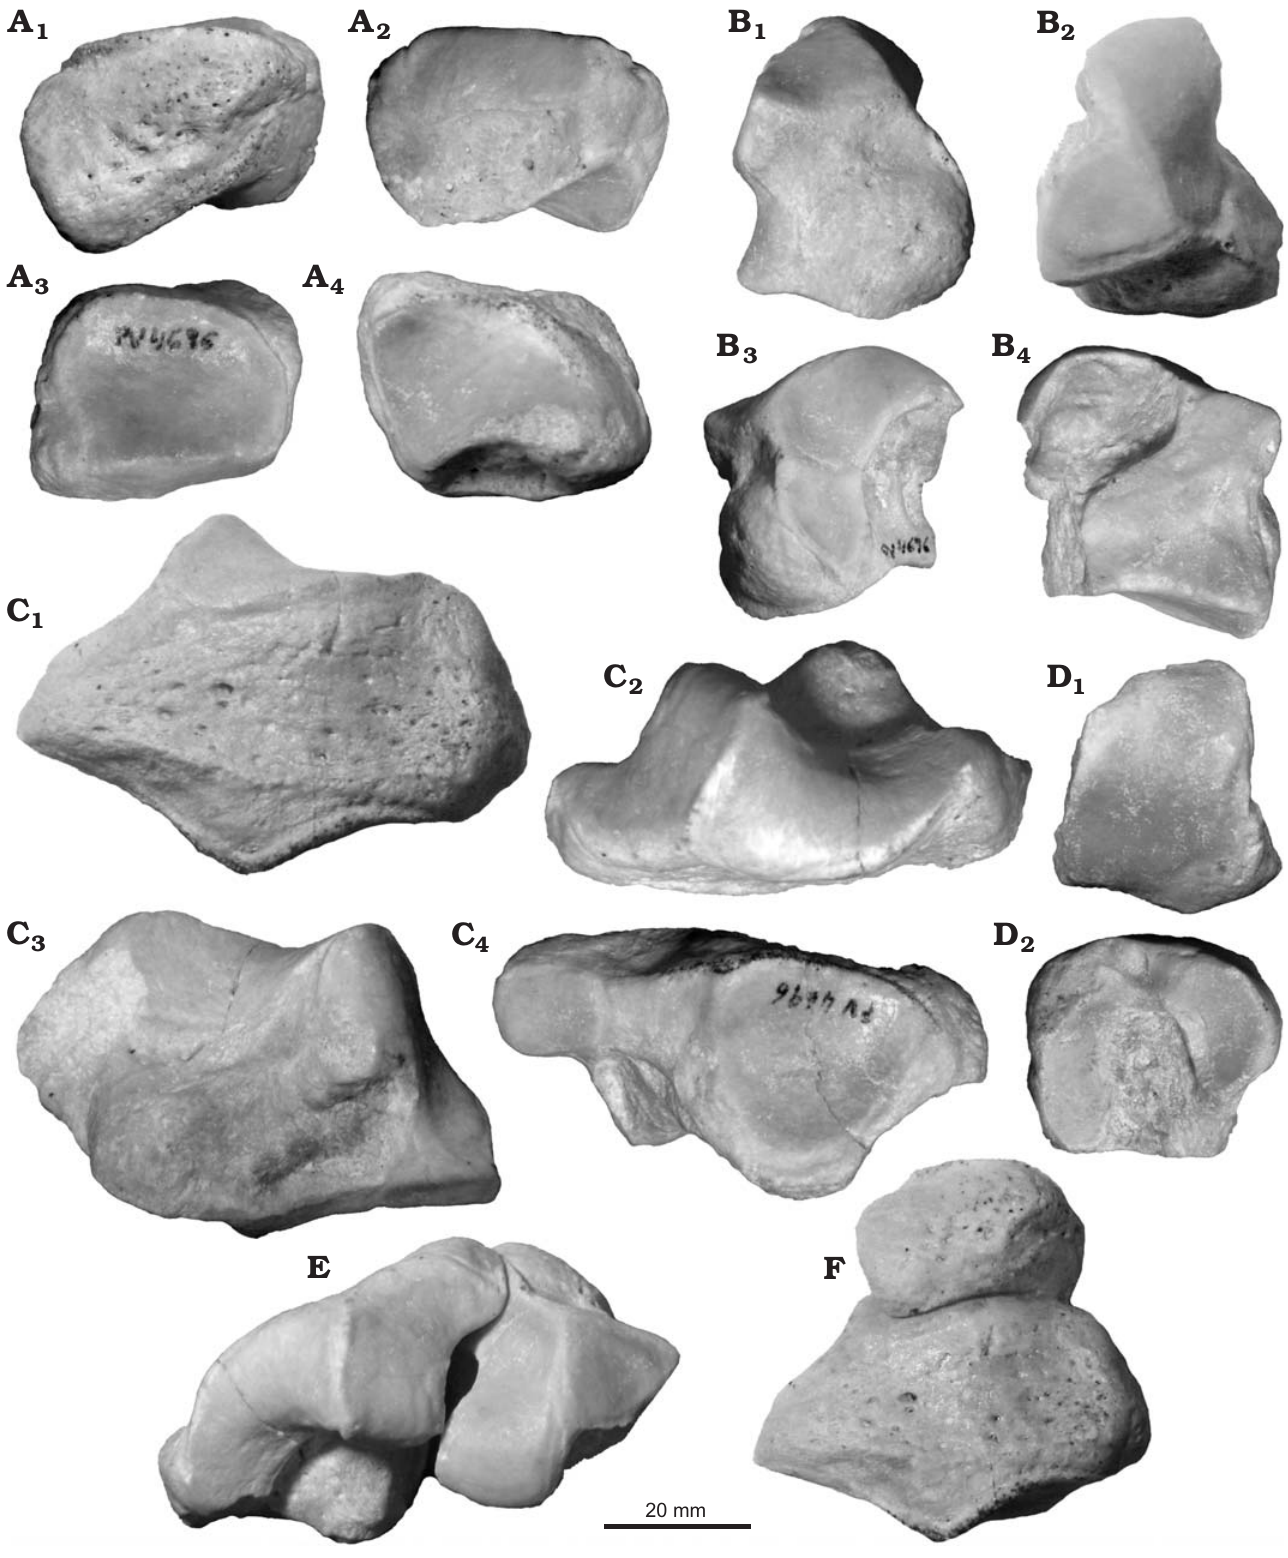
Fig. 4. Left carpals and metacarpal of leontiniid notoungulate Gualta cuyana Cerdeño and Vera, 2015 from Quebrada Fiera, Mendoza, Argentina; Deseadan SALMA (late Oligocene), MCNAM-PV 4696. A . Pyramidal, anterolateral (A 1 ), medial (A 2 ), proximal (A 3 ), and distal (A 4 ) views. B . Magnum, anterior (B 1 ), proximal (B 2 ), lateral (B 3 ), and medial (B 4 ) views. C . Unciform, anterolateral (C 1 ), proximal (C 2 ), medial (C 3 ), and distal (C 4 ) views. D . Proximal fragment of McIII, proximal (D 1 ) and lateral (D 2 ) views. E . Magnum and unciform in anatomical position, proximal view. F . Pyramidal and unciform in anatomical position, anterolateral